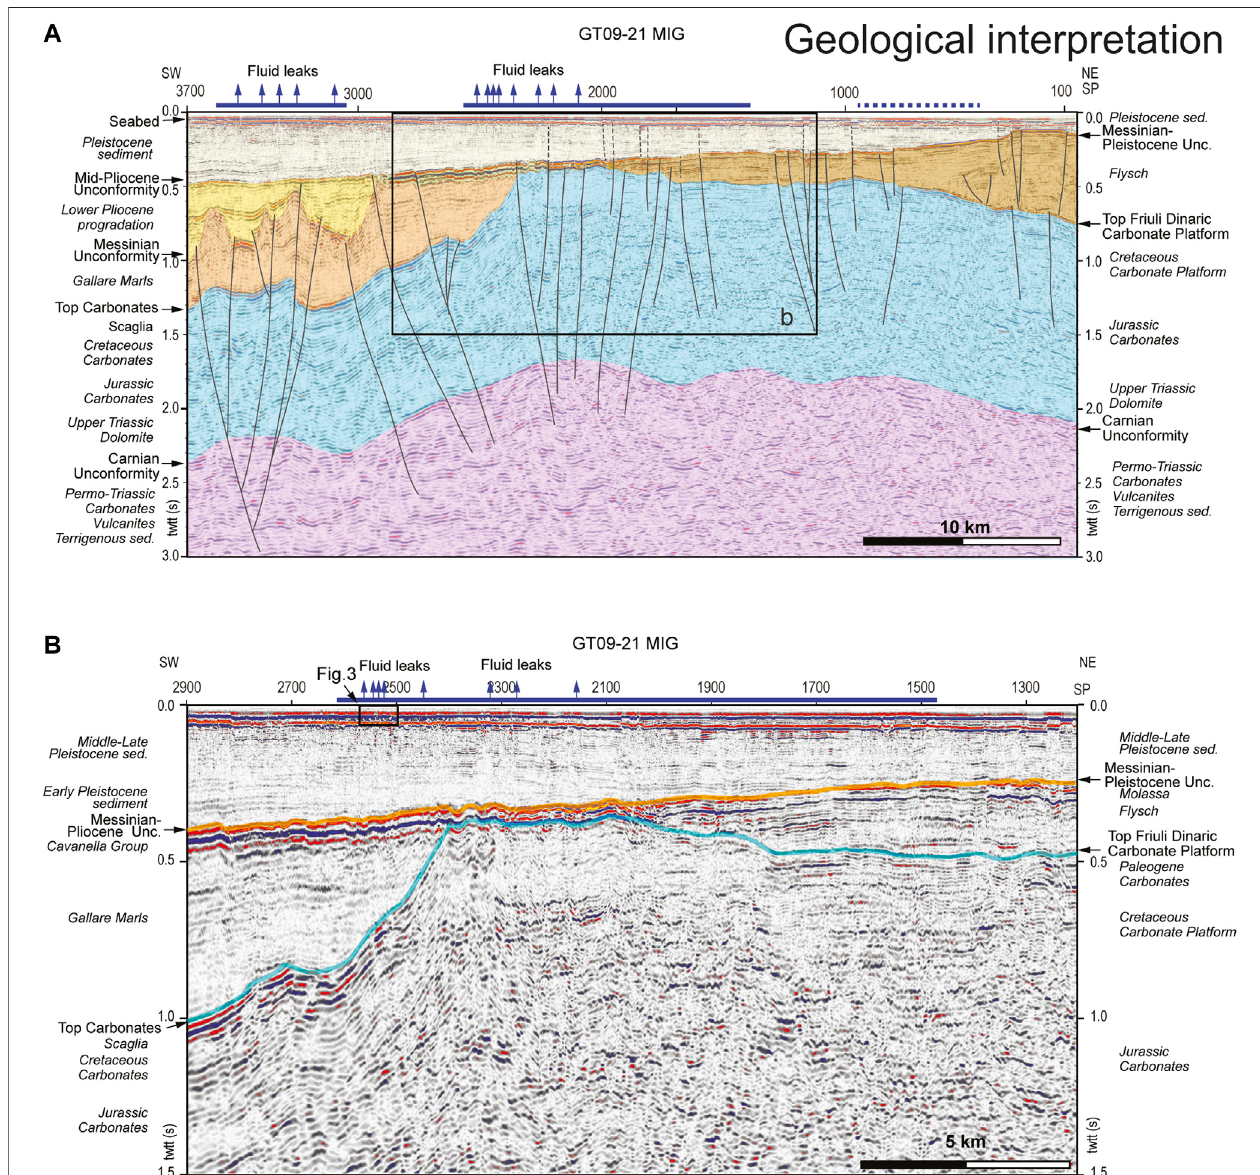
FIGURE2| Time-migrated seismicpro fi leGT09 – 21: (A) seismo-stratigraphic interpretation(see Figure1 forlocation); (B) sectionoftheseismicpro fi leanalyzedin the present work with the picked horizons. Blue lines along the pro fi le indicate evidence of fl uids within the sediment, dashed line where the fl uids are less evident or discontinuous, and the blue arrows indicate the location of fl uid seeps in the water column.